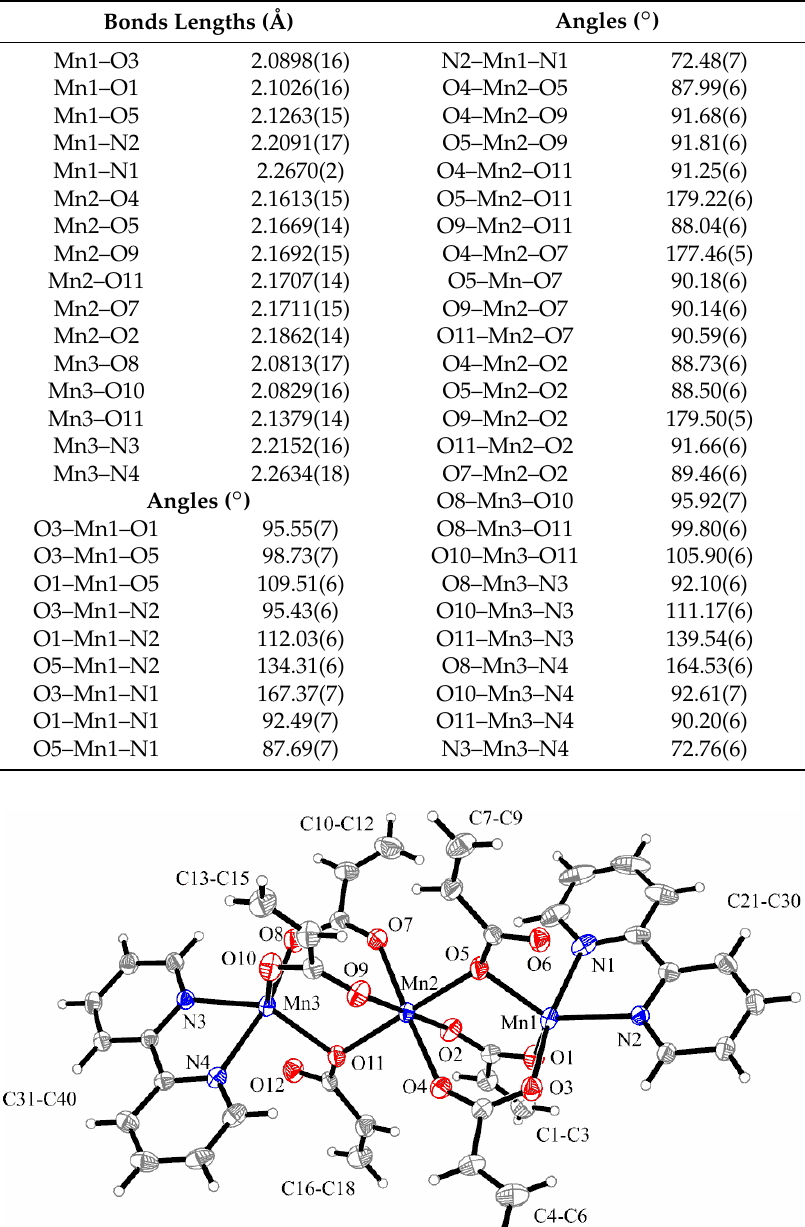
Table 2. Selected bond lengths (Å) and angles ( ◦ ) for [Mn 3 (2,2 (cid:48) -bipy) 2 (C 3 H 3 O 2 ) 6 ] ( 1 ).